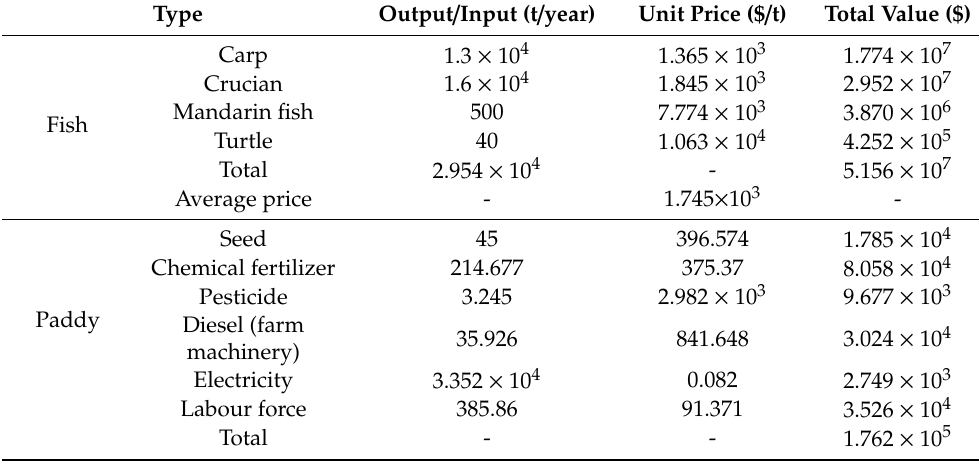
Table 1. Annual average output / input value, unit price and total value of fish and paddy in Nansi Lake wetland (2012